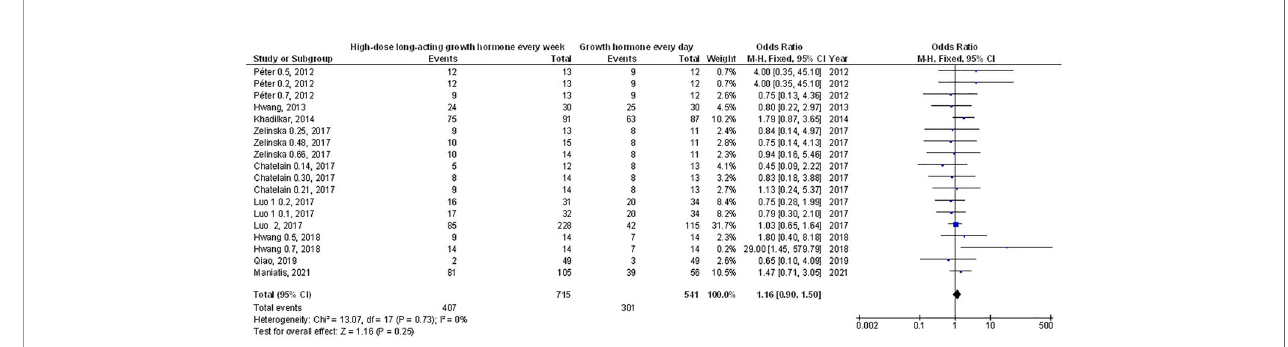
FIGURE 7 | Forest plot of the incidence of adverse events in long-acting growth hormone replacement therapy compared to daily growth